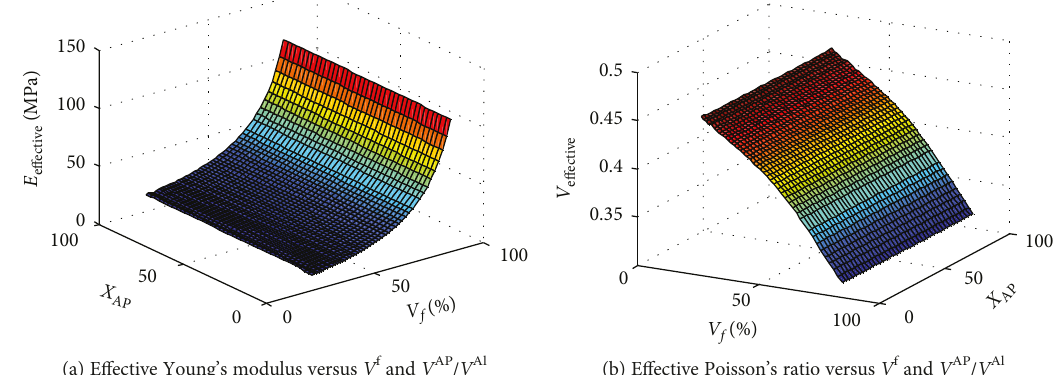
Figure 8: E ff ective properties of solid propellants versus V